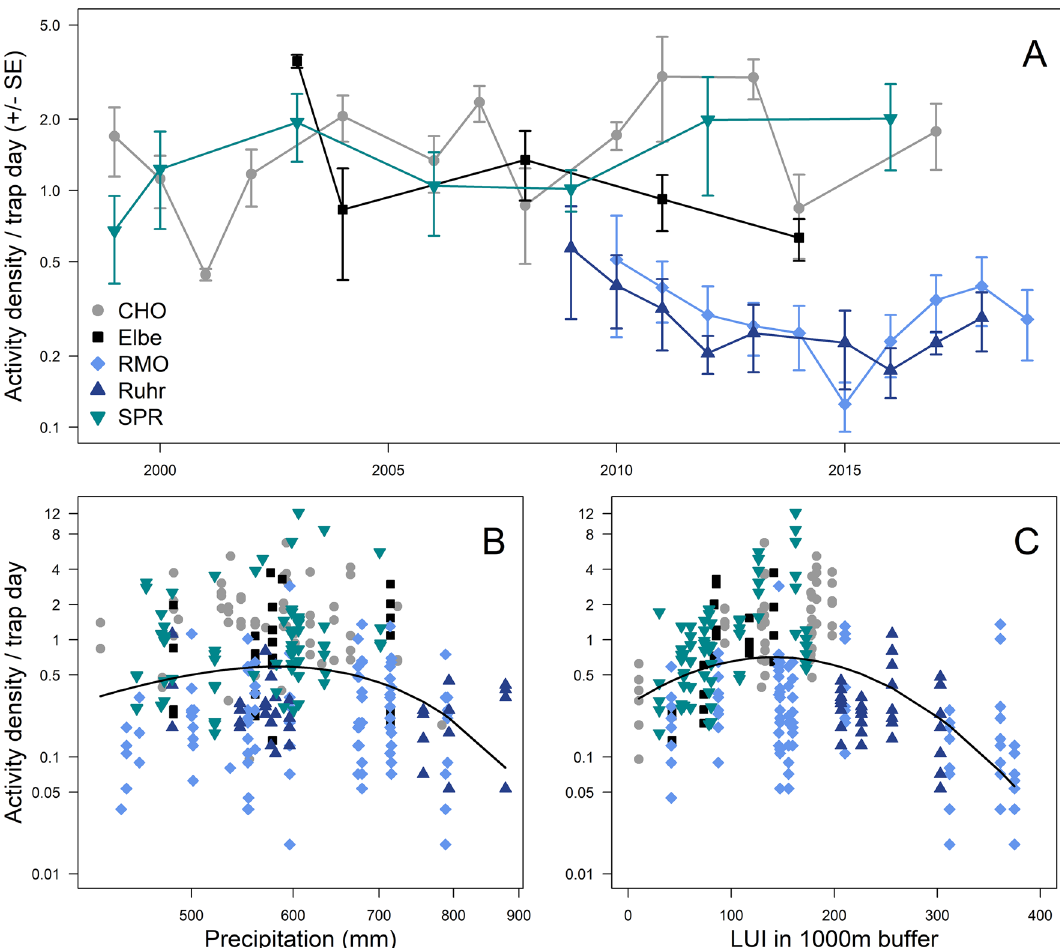
Figure 3. Spatio-temporal variation of activity densities across the five regions ( A ) and activity density responses to significant drivers from the overall model (Table 3): Precipitation ( B ) and land use intensity (LUI) around 1000 m of sampling sites ( C ). Error bars in Panel A represent one standard error. Points in Panels B and C represent activity densities within each site and year.